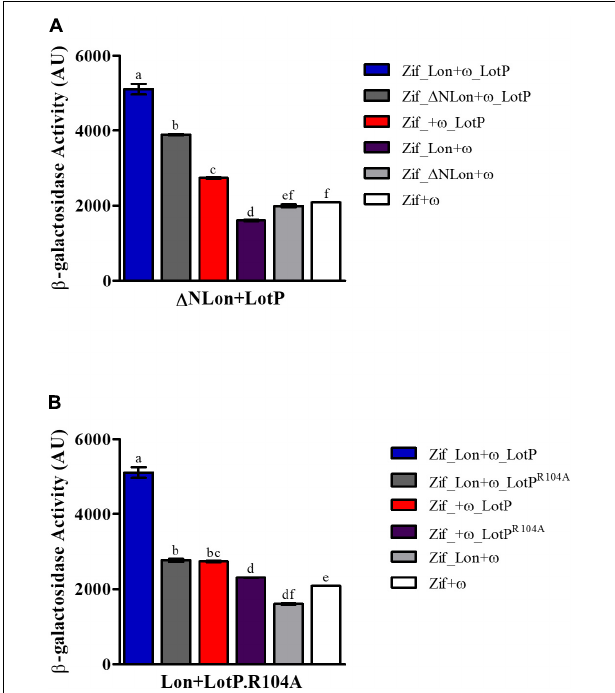
FIGURE 6 | Structural factors that affect Lon–LotP interactions. β -Galactosidase activity was determined using Escherichia coli strain KDZif1DZ as a reporter strain, transformed with the different construction of the plasmid pACTR-AP-Zif (Zif) and pBRPG- ω ( ω ). Assays were performed at different stages of exponential growth (OD 600 = 0.3, 0.6, 0.9), while only OD 600 = 0.9 is shown. (A) Interaction between LotP and (cid:49) NLon. (B) Interaction between LotP R104A and Lon protease. β -Galactosidase activity is shown as the average ± SD in arbitrary units (AU) from biological triplicates. Variance was calculated by one-way ANOVA with a Tukey’s post hoc test, p = 0.05. Significant difference between two samples is denoted by different letters.